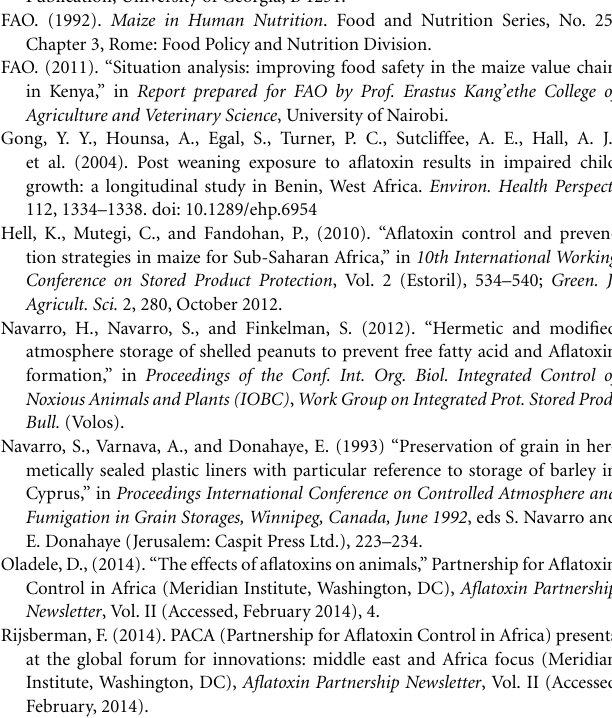
FIGURE 7 | Bunker in Jordan storing wheat.